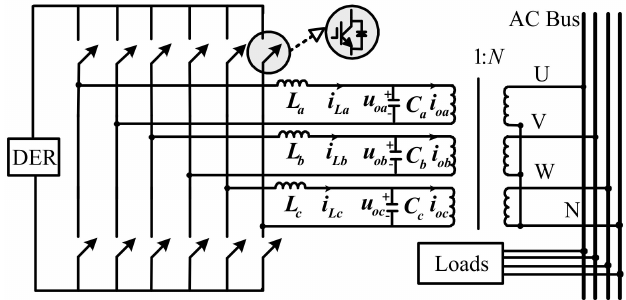
Figure 2. Structure architecture of the combined three-phase inverter.